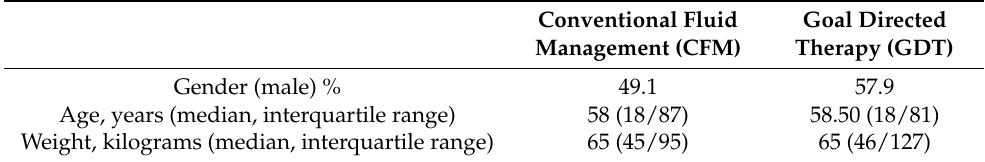
Table 1. Demographic Data.